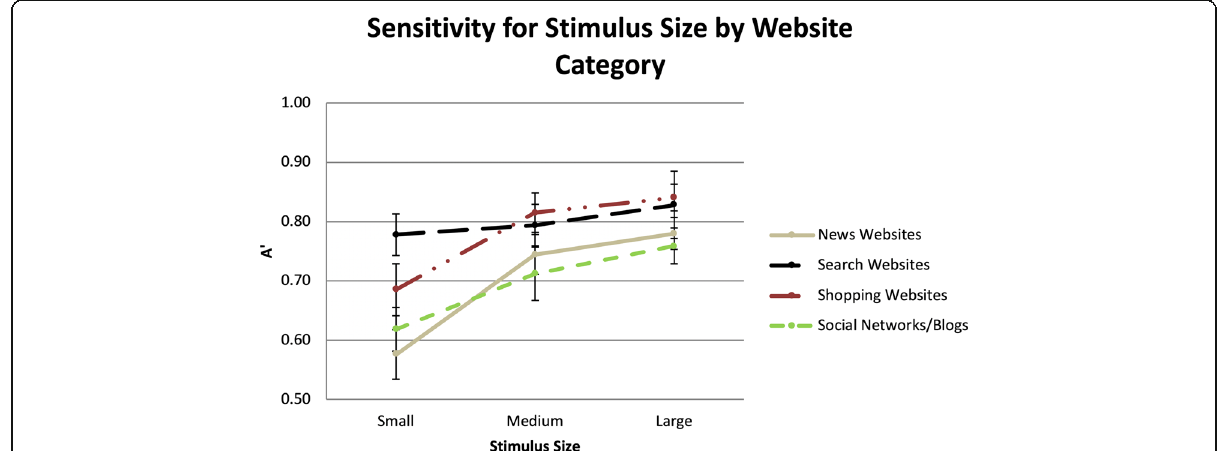
Fig. 11 Sensitivity for detecting websites in each of the different sizes and resolutions. Error bars are within-subjects 95% confidence intervals (Cousineau, 2005; Morey,